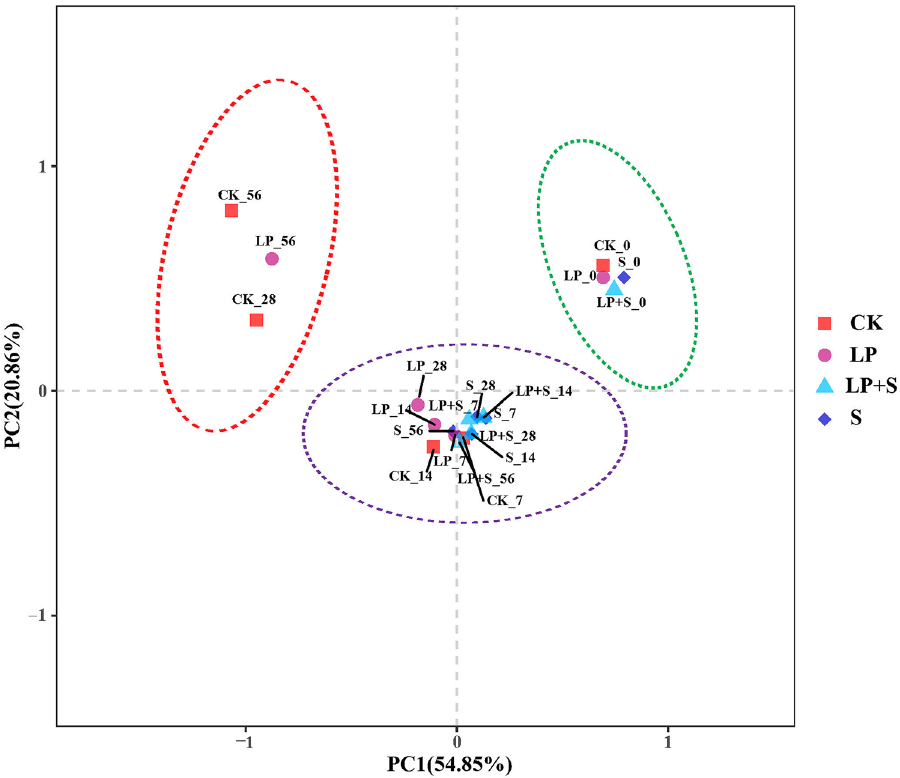
Figure 4. The principal component analysis of the clostridial community diversity at the genus level. CK, control; LP, Lactobacillus plantarum ; S, sucrose; LP + S, the addition of both sucrose and Lactobacillus plantarum